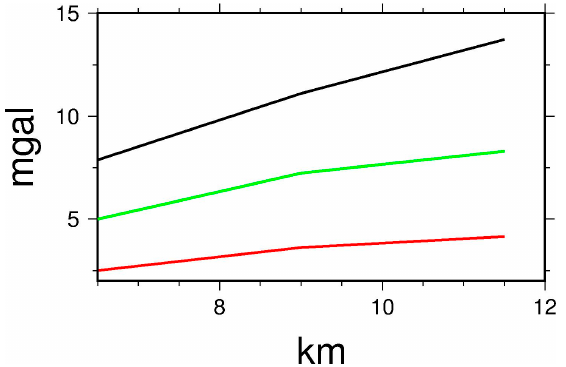
Figure 7. The Relationship between Errors Effect and Downward Continuation Altitude in Tibetan Plateau (Red line: REE -Std 2 mgal, green line: REE -Std 4 mgal, black line: SEE ).